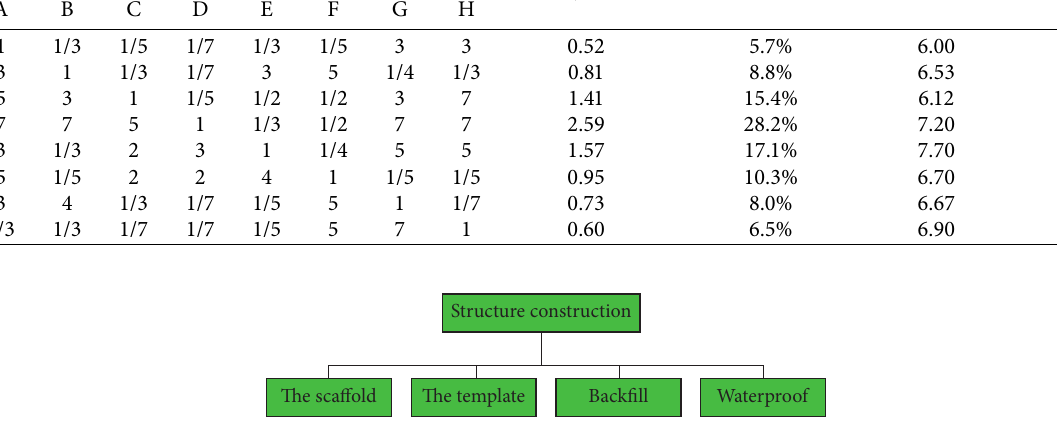
Figure 5: Structural construction risk hierarchy